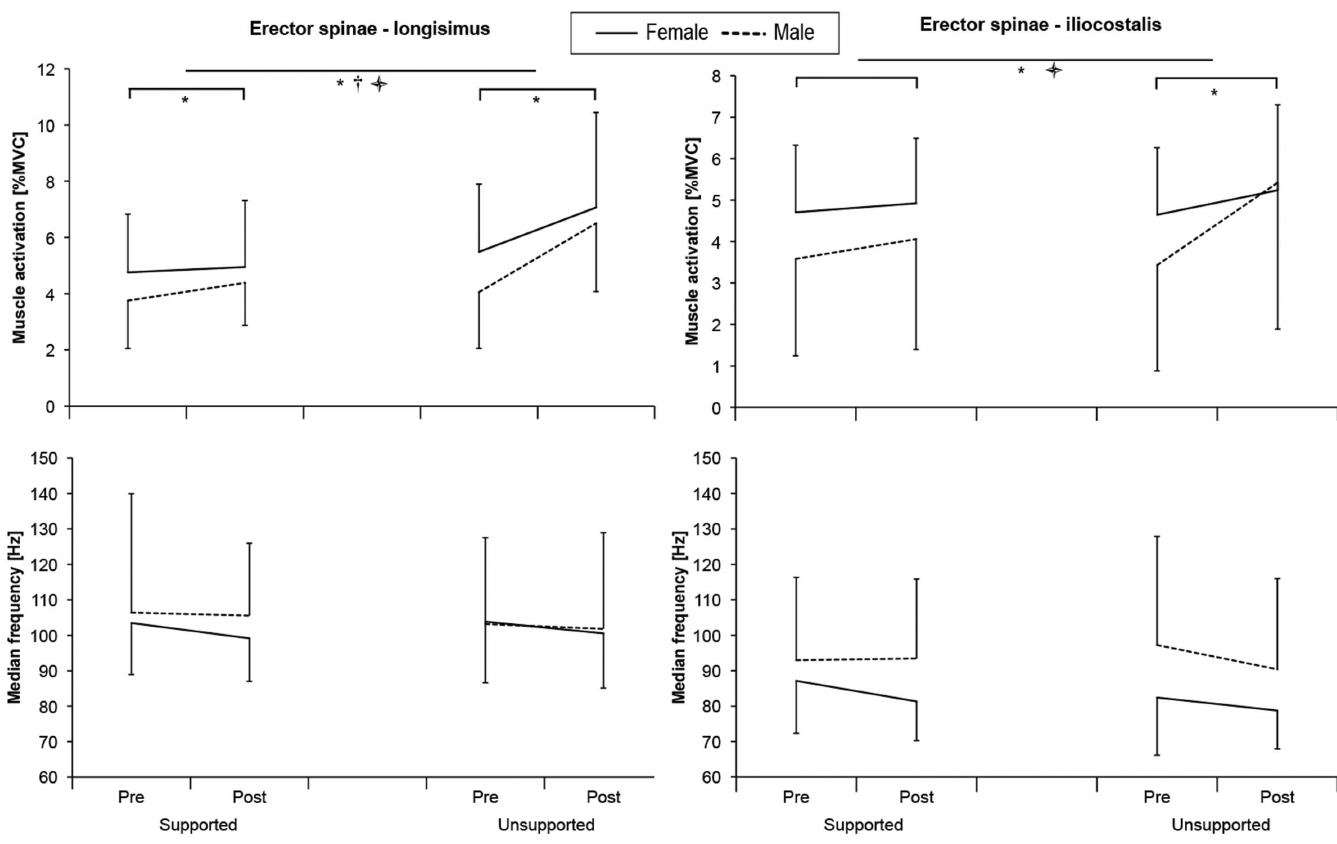
Fig 4. Mean muscle activation expressed as a percentage of maximal voluntary contraction and median frequency measured while resisting the 60N pushing force applied at the level of T10 spinous process before (Pre) and after (Post) intermittent flexion for male and female participants in support and unsupported conditions. * — Time effect (p < .05); † - Condition effect (p < .05); - Interaction effect (p <